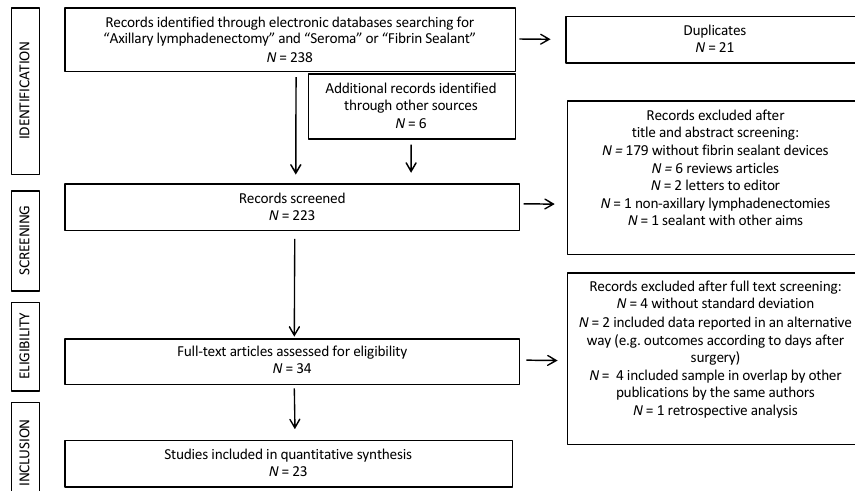
Figure 1. PRISMA flow diagram on the meta-analysis process.